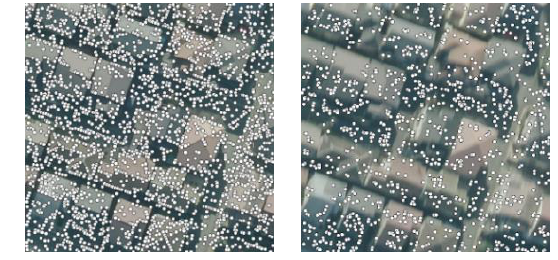
Figure 3. Position of key points (Left: clear image, Right: blurry image)